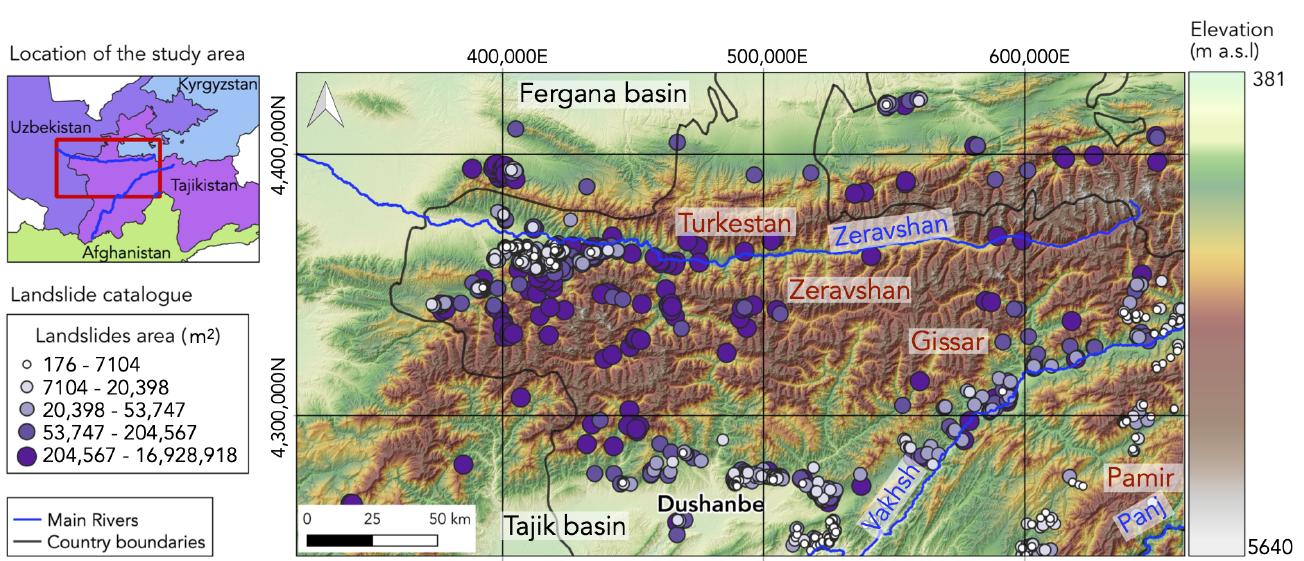
Figure 1. Location of the study area (Tajik Tian Shan) and spatial distribution of known landslides from the Tian Shan Geohazards Database [14] and this